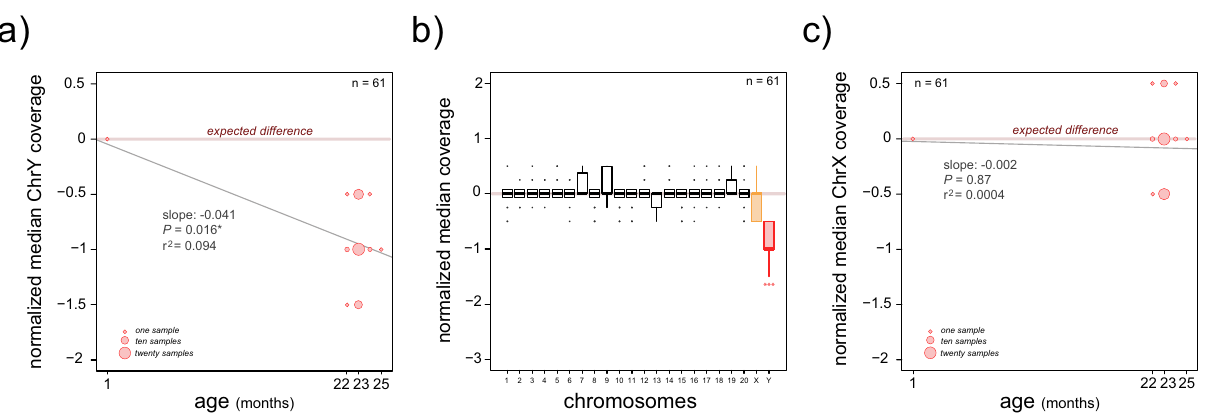
Fig. 2 Normalized sequencing coverage of full Y and X chromosomes in samples from young and old rats. a Dot plot of the normalized median sequencing coverage of ChrY compared to the age of the rats. The observed sequencing coverage of the Y and X chromosomes was standardized using an expected value calculated as half of the median autosomal sequencing coverage (both sex chromosomes are single copy in the male genome). Signi fi cant differences, Linear Model: lm[median.chrY.coverage ~ age], * indicates P < 0.05. b Boxplot of the normalized median sequencing coverage for the 22 chromosomes in rats (20 autosomes and two sex chromosomes). The observed coverage for each autosome was normalized by the median coverage across autosomes. Only half of the autosomal coverage was used to normalize values from Y and X chromosomes. Signi fi cant differences, Mann – Whitney U test against a distribution with a fi xed median of 0 (similar to the expected value). P values were Benjamin – Hochberg corrected: *** indicates P < 0.001. Error bars, maximum and minimum values, excluding outliers. c Dot plot of the normalized median sequencing coverage of chromosome X compared to the age of the rats. The observed coverage of the Y and X chromosomes was standardized using half of the median autosomal coverage. Signi fi cant differences, Linear Model: lm[median.chrX.coverage ~ age]. Sample sizes are indicated in each plot (n